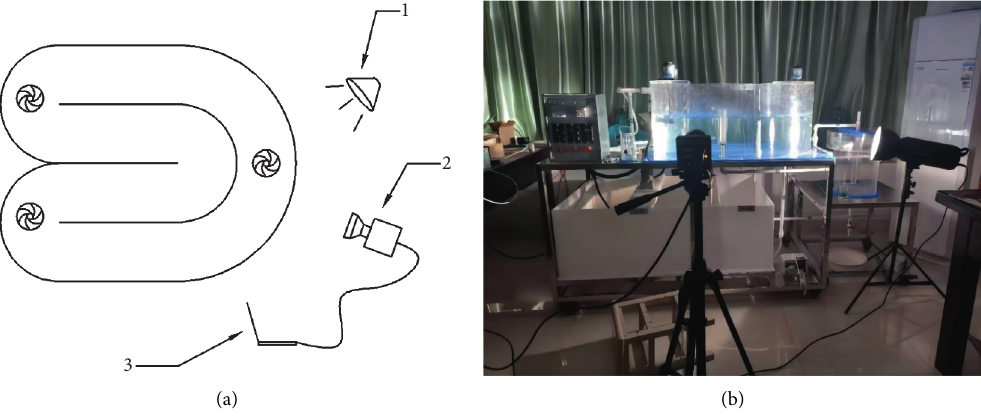
Figure 10: High-speed camera with LED lights.